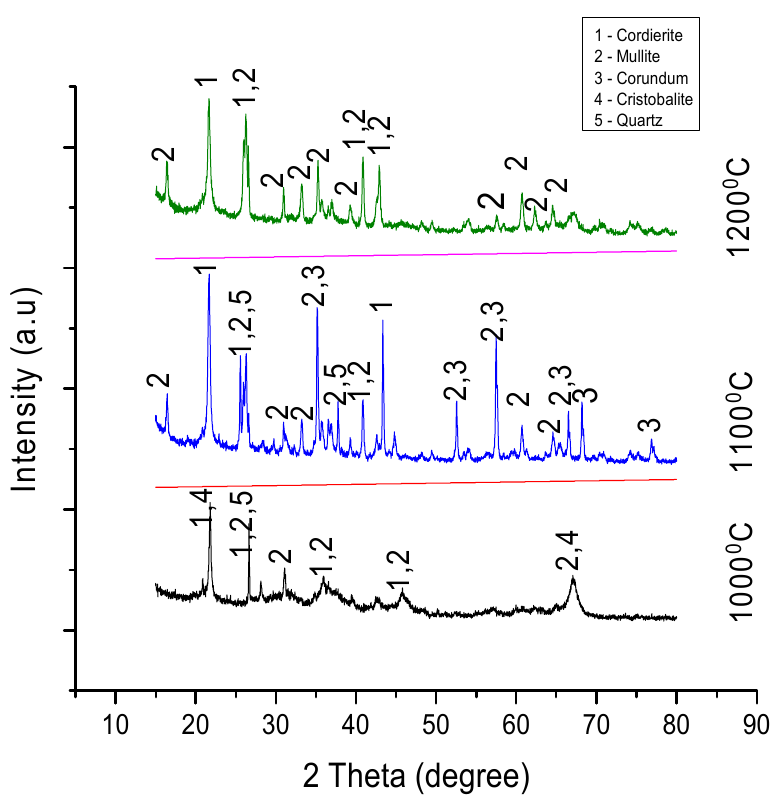
Figure 6. XRD peaks for samples in experiment B sintered at 1000 °C, 1100 °C, and 1200 °C.